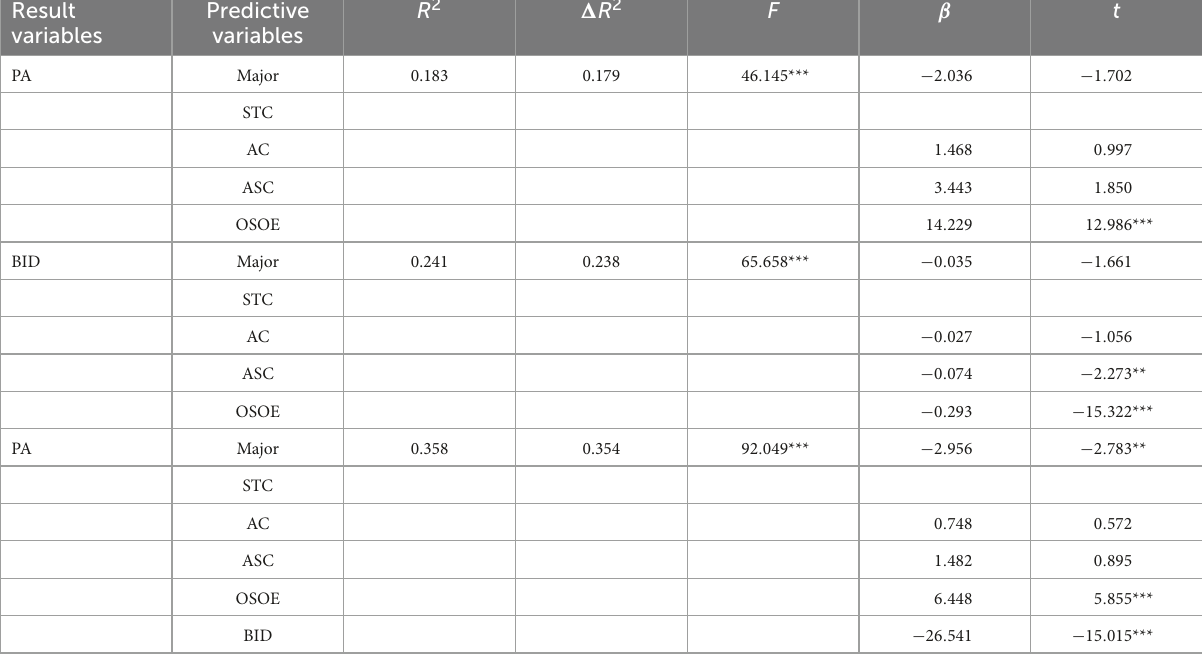
TABLE 3 Regression analysis of the mediation model.